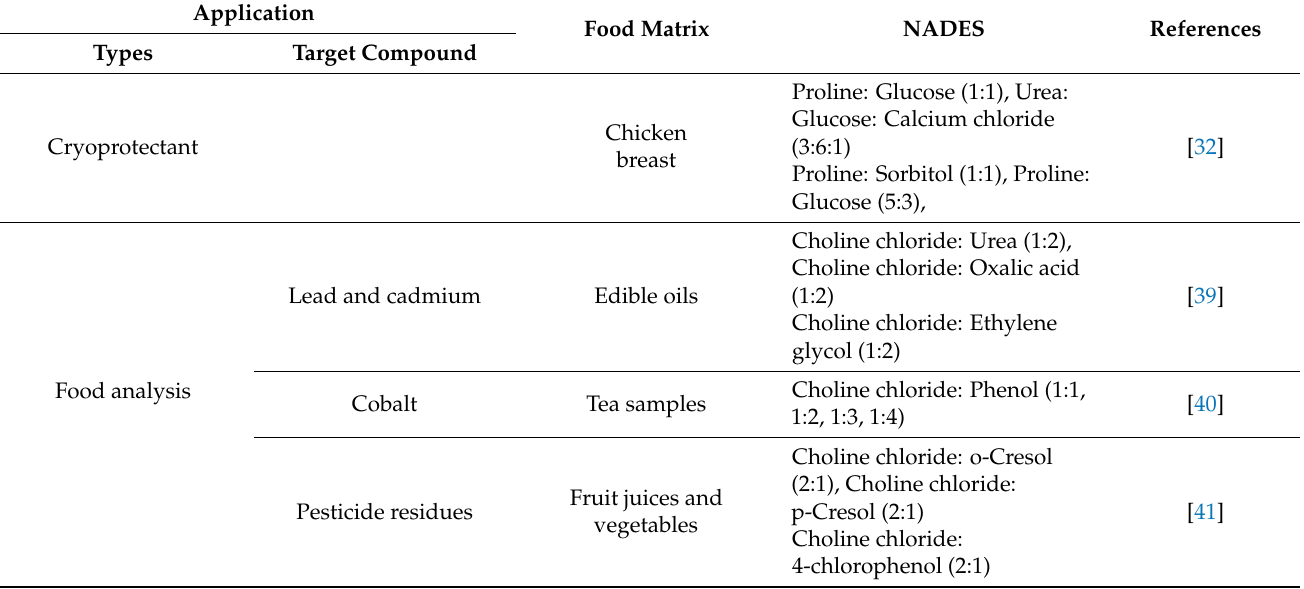
Table 1. Application of